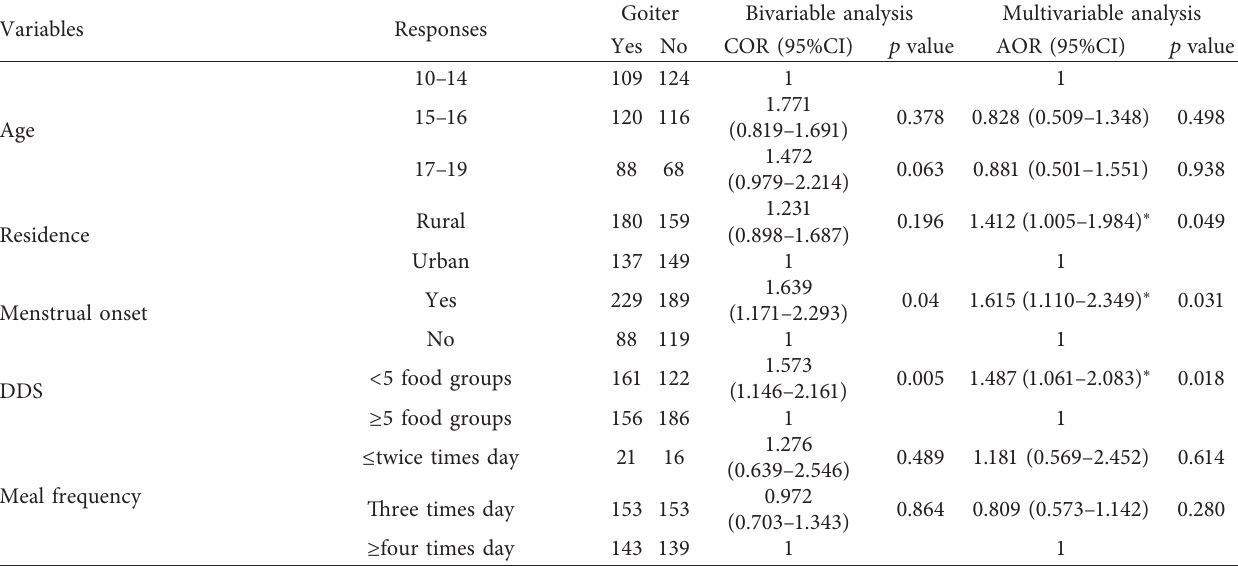
Table 5: Bivariate and multivariate analysis of factors associated with goiter among adolescent girls,